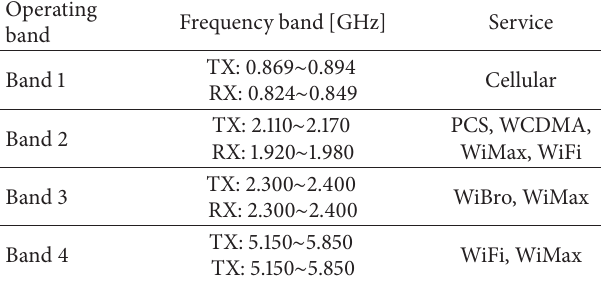
Table 1: Operating bands of the multiband base-station